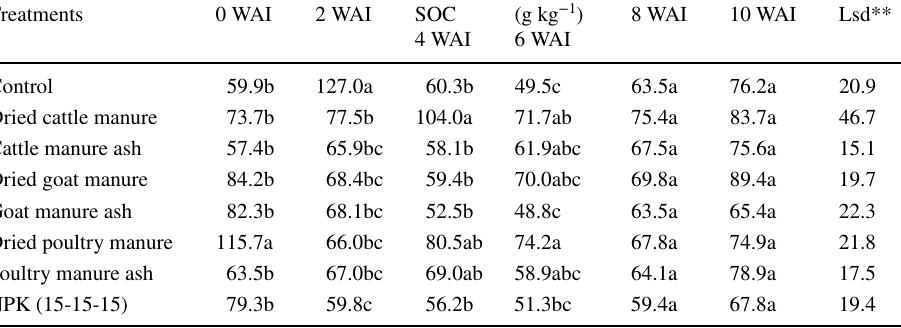
Means with the same letter(s) within the same column are significantly different at p < 0.05 WAI weeks after